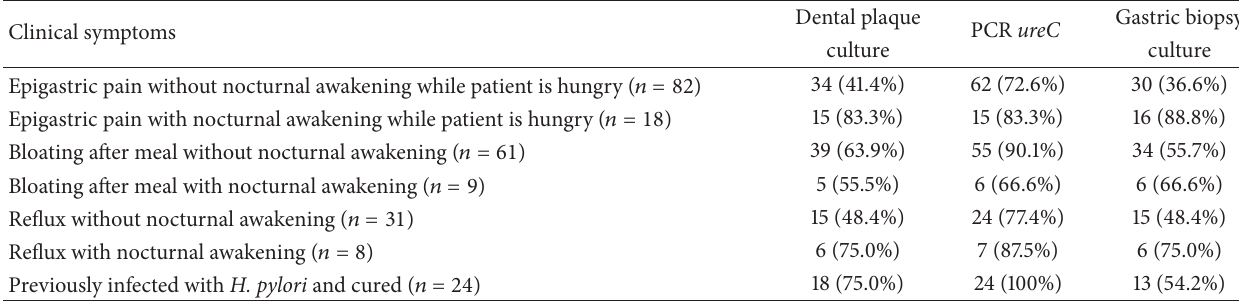
Table 1: Relationship of clinical symptoms and frequency of H. pylori detected in dental plaque and gastric biopsy’s dyspeptic patients. Clinical symptoms